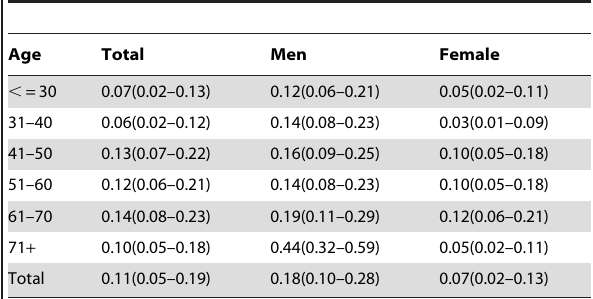
Table 1. The incidence of PE in hospitalized patients by age and gender in China (%) during 12 years (from 1997 to 2008).